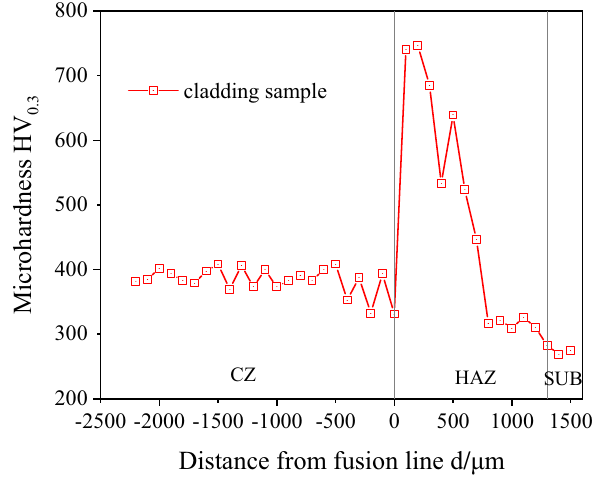
Figure 3: Microhardness distribution of cladding